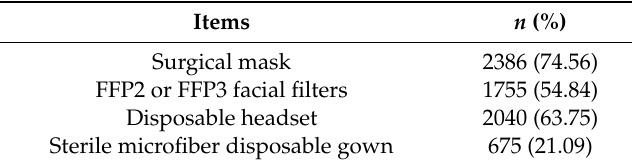
Table 7. Personal protective equipment (PPE) and devices adopted by the